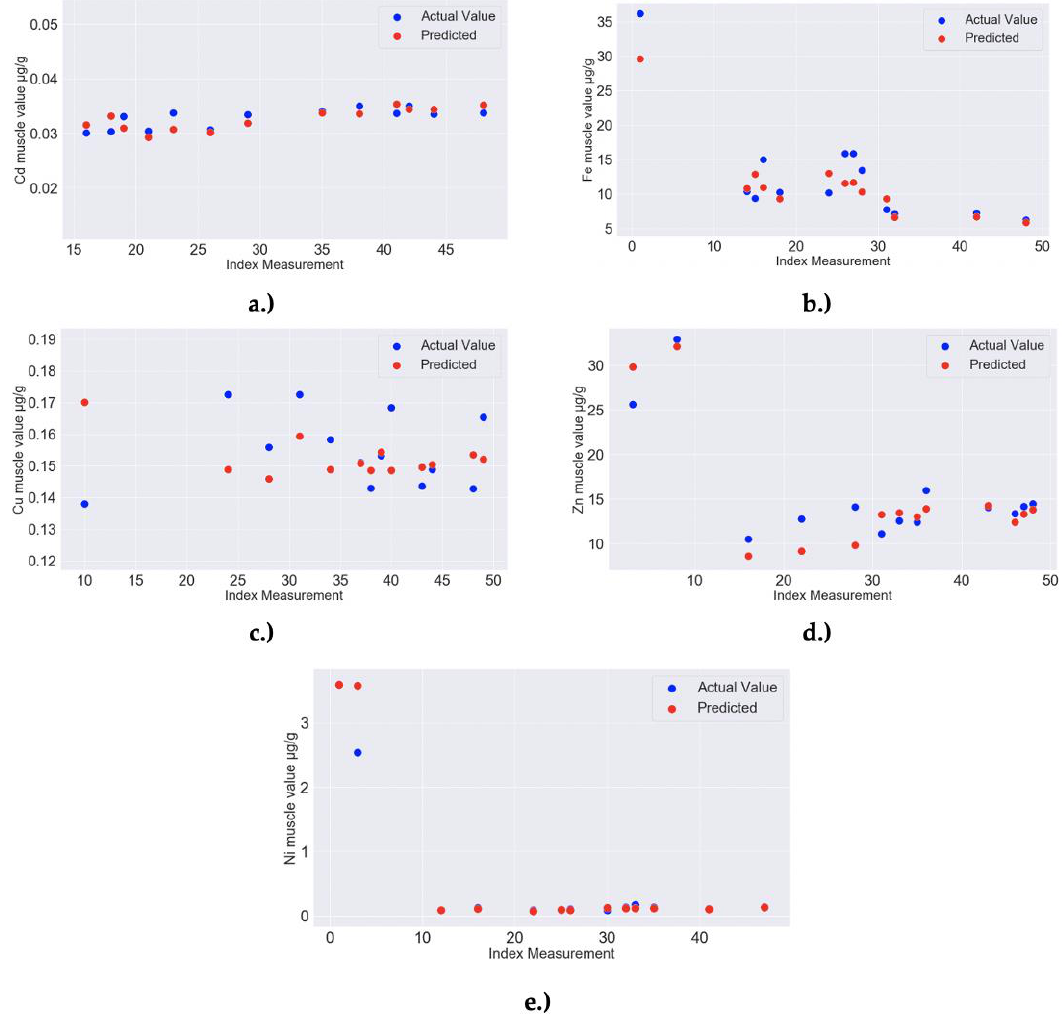
Figure A6. Prediction of heavy metals concentration for turbot muscle tissues—actual values vs. predicted value for fourth dataset group—Section 2.2.5 (( a ). prediction for Cd concentration; ( b ). prediction for Fe concentration; ( c ). prediction for Cu concentration; ( d ). prediction for Zn concentration; ( e ). prediction for Ni concentration).